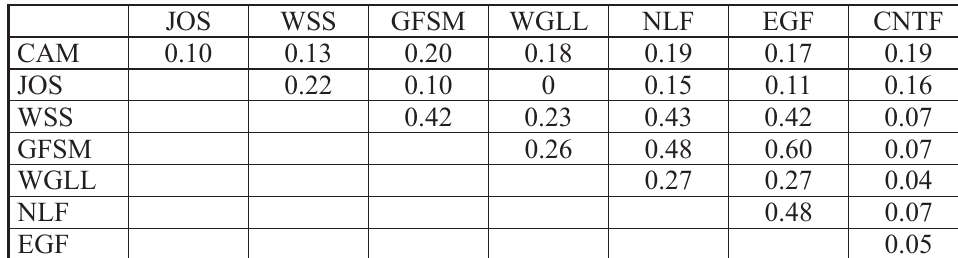
Table 3. Incidence based similarity indices (a: Jaccard; b: Sørensen) for Tephritidae between the ecoregions in the study area (abbreviations: see Table 2) (range 0-1, with 0 being no similarity and 1 being complete